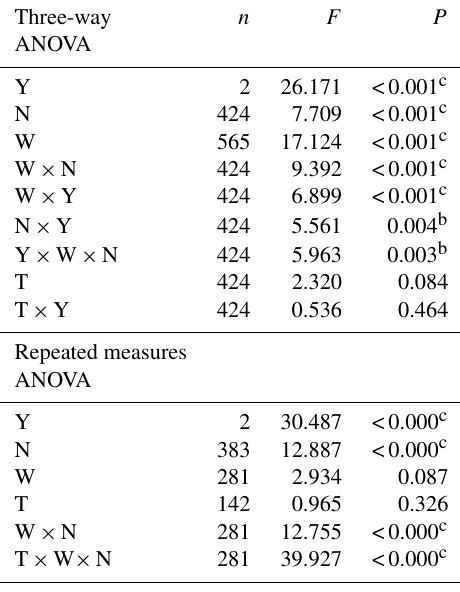
Table 2. Tests of significance of year (Y), warming (T), precipita- tion (W) and nitrogen addition (N) on soil respiration ( R s ) using multivariate ANOVA ( F and P values). The cumulative effect of precipitation, N deposition and warming on R s in 2015 and 2016 ( F and P values) as assessed by repeated measures ANOVA. Su- perscripts a, b and c indicate significant effects at P <0.05, 0.01 and 0.001,